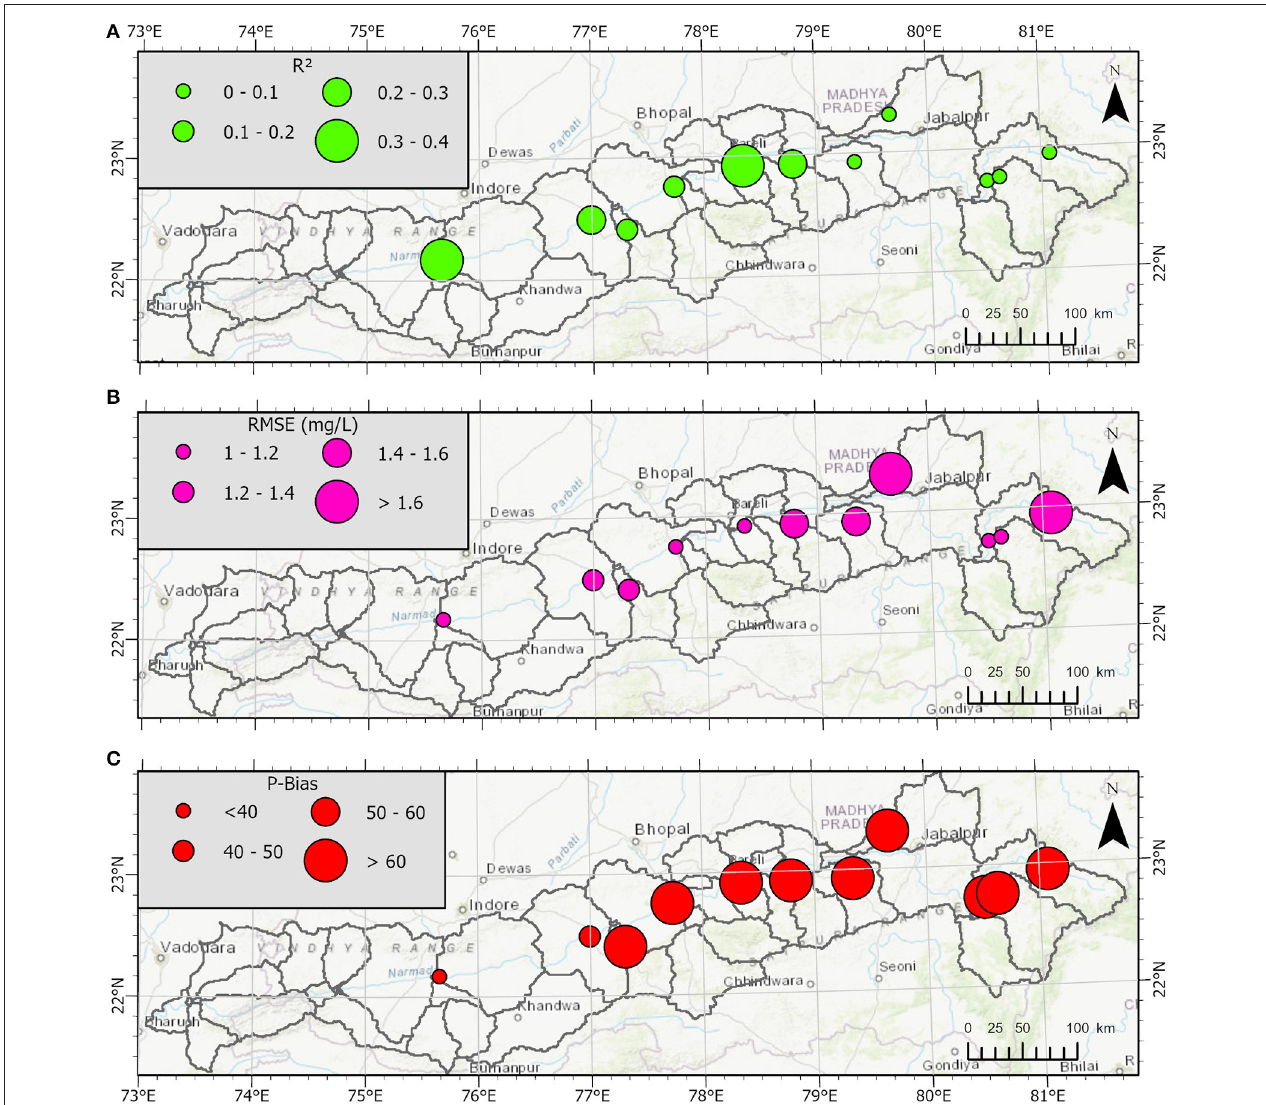
FIGURE 5 | (A–C) : SWAT model performance statistics for nutrient simulation. (A) Correlation coefficient squared, (B) Root mean squared error, (C) : Percent bias, for 11 gauge locations inside the Narmada River